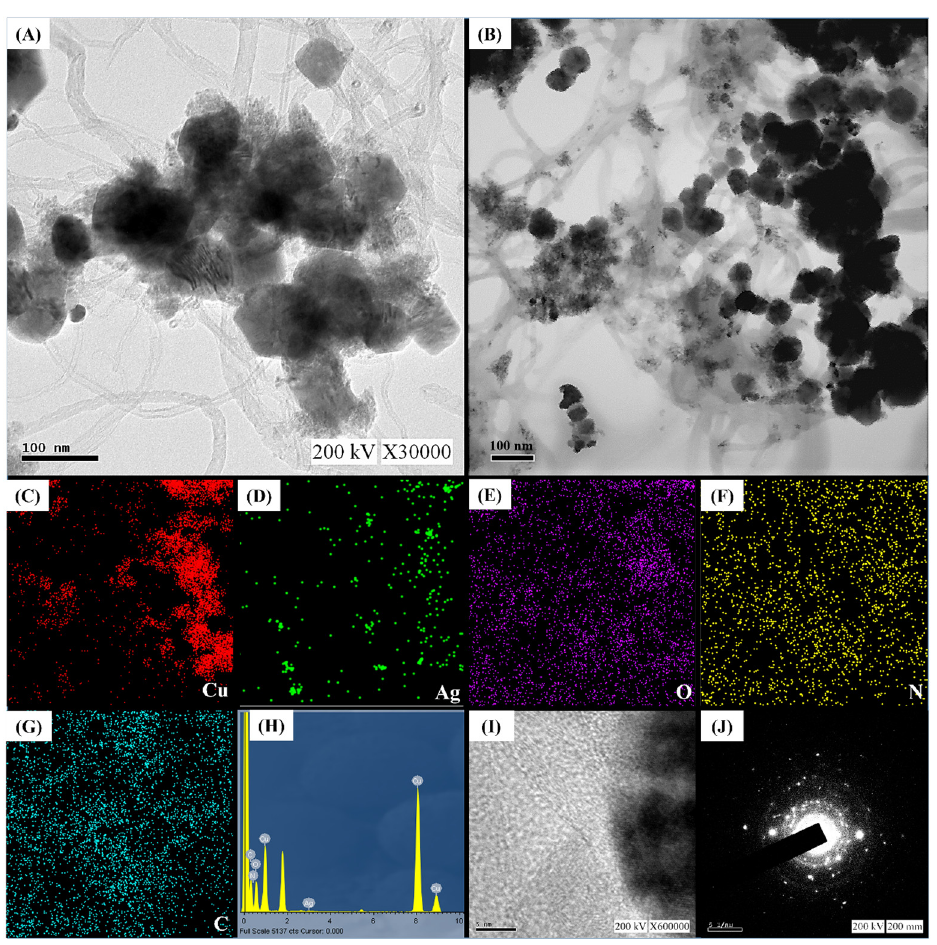
Figure 3. ( A ) HR-TEM, ( B ) HAADF-STEM, ( C –G) corresponding elemental mapping of copper, silver, oxygen, nitrogen, and carbon, ( H ) EDX, ( I ) lattice fringes, and ( J ) SAED patterns of AgCuO NPs/fCNTs.